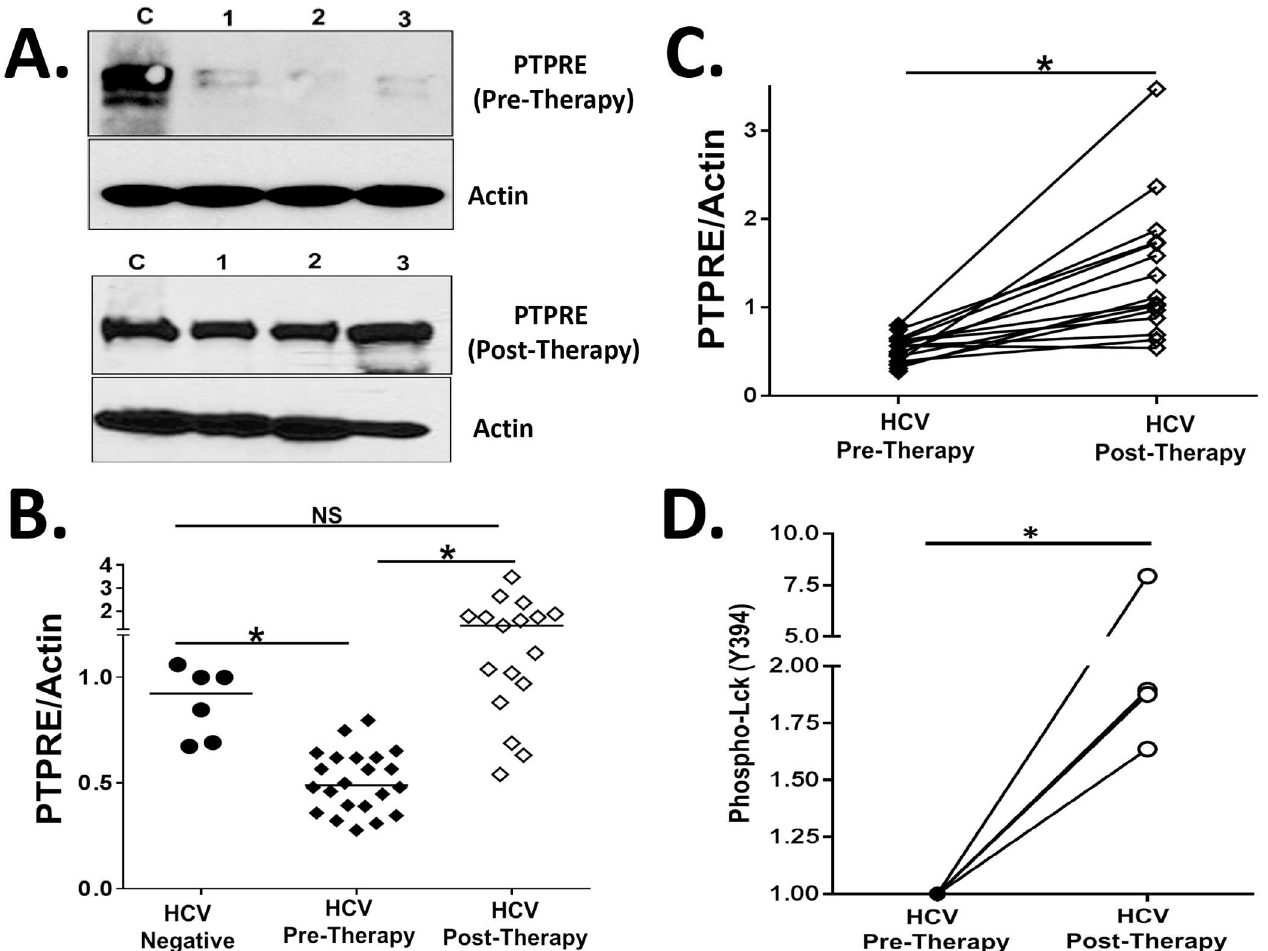
Fig 7. PTPRE expression is reduced in Peripheral Blood Mononuclear Cells (PBMCs) obtained from HCV-infected humans and restored following curative HCV therapy. PTPRE levels in PBMCs obtainedfrom three HCV-infected individuals(1, 2, 3) and uninfectedcontrol (C) subjects before and followingdirect acting antiviral HCV therapy (A) as determinedby immunoblot analysis. PTPRE expressionrelative to actin in the PBMCs obtained from healthyblood donors, and HCV-infected subjects before or followingcurative HCV therapy (B). PTPRE levels relativeto actin in PBMCs in individualHCV-infected subjects before and followingHCV therapy (C). PBMCs from four HCV-infected subjects prior to and followingHCV therapy were stimulatedwith anti-CD3. Lck activation(Y394 phosphorylation) was measuredand normalized to GAPDH (D). * P <